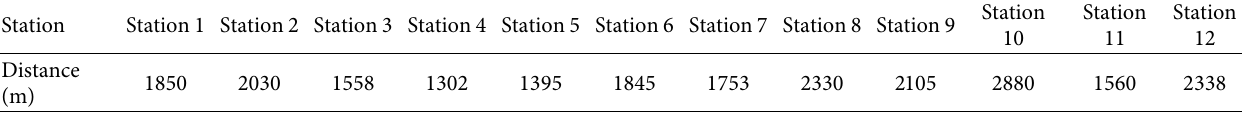
Table 1: Running distance between stations.